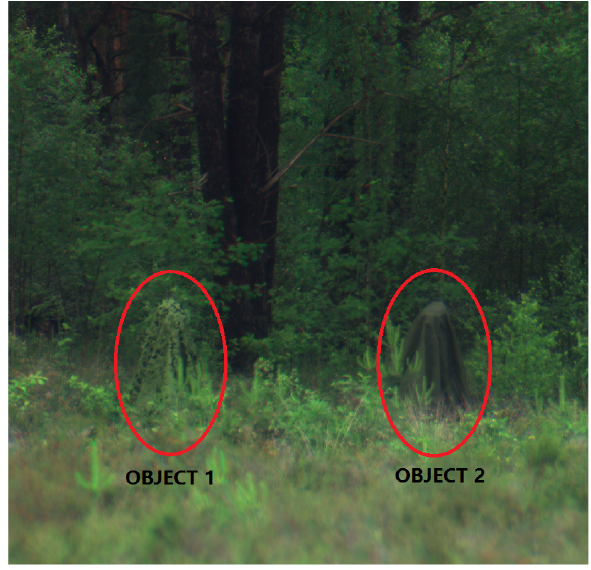
Figure 4. Concealed objects in a woodland